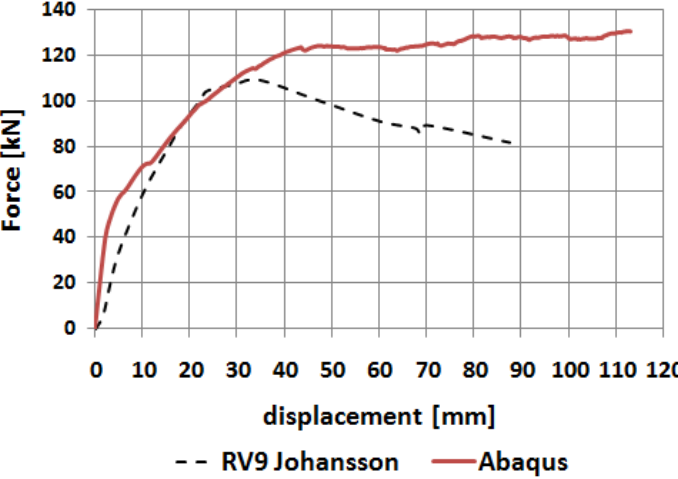
Figure 33. Force – displacement relationships obtained in FEM analysis and laboratory tests. Figure 33. Force–displacement relationships obtained in FEM analysis and laboratory tests. A crack pattern obtained in the FEM analysis is presented in Figure 34 for four selected time steps, where the time value t = 1 s is equivalent to the maximum displacement in the displacement-control procedure (120 mm). The first figure presents a map of PEEQT at the very beginning of the loading process. Despite not being particularly large, a clear crack can be seen propagating from the concave angle of the corner zone. Using formula (18) the authors calculated a maximum crack width with a value of w = 0.25 mm. Afterwards two new concurrent cracks appear further from the concave angle as shown in the second map of PEEQT. At this step time, the maximum crack width is w = 0.57 mm which is a very large value in comparison to the typical values of ultimate crack widths given by codes and handbooks. The excessive value of the crack width is in accordance with findings from the previous section that a reinforcement detail containing only one diagonal bar is not recommended for a corner under opening bending moment. In the third map, a new crack propagating in the corner zone where the reinforcement is loop-shaped is apparent. The current crack width is w = 1.84 mm. The fourth figure presents a PEEQT map from the end of the FEM computations and some new cracks and extensions of the previous cracks appear. Eventually the crack width reaches w = 8.10 mm. The final crack pattern can be compared with the crack pattern obtained in Johansson’s laboratory test—see Figure 35. There are similarities between the FEM and laboratory results—firstly, the comparable crack propagation from the concave corner and cracks outside the corner zone perpendicular to the axes of adjacent elements. Secondly, there is also a very similar extension of the crack propagating from the concave corner. However, there is one clear difference—there are cracks located along the loop-shaped fragments of the reinforcing bars and none of them appears in the FEM analysis. Despite this, a fairly strong agreement between the FEM simulations and laboratory test is observed and therefore the CDP model with the properly calibrated parameters can be recommended for practical